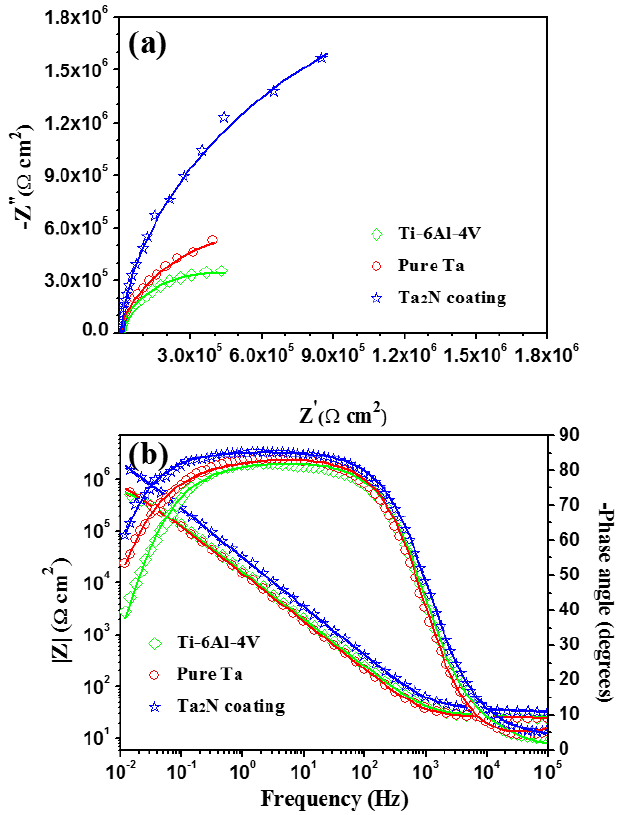
Figure 9. ( a ) Nyquist and ( b ) Bode plots of uncoated Ti-6Al-4V, commercially pure Ta and the Ta 2 N coating at respective open circuit potentials in Ringer’s physiological solution at 37 °C. Symbols are experimental data and solid lines are fitted results.